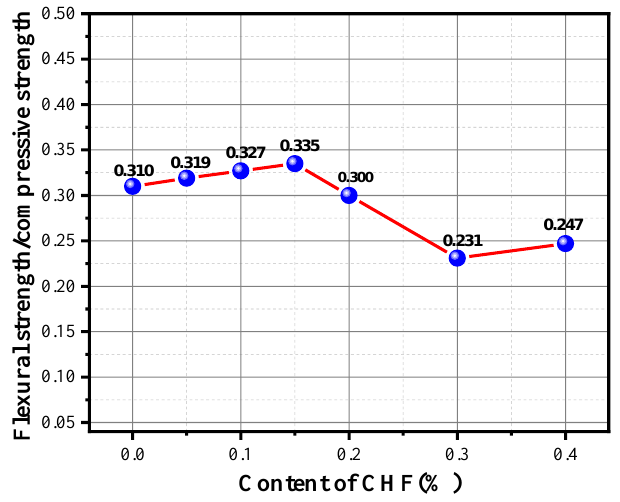
0.0 Figure 15. Influence of the content of CHF on the F/C of the material. Figure 15. Influence of the content of CHF on the F/C of the The change in the porosity of foamed concrete will influence its strength. Figure 16 shows the corresponding relationship between the porosity of the foamed concrete and its 28-day compressive strength and flexural strength. Figure 16. Corresponding relationship between porosity and strength of CHF foam concrete. The relationship between the density and the compressive strength and flexural strength of the cow hair fiber-reinforced foam concretes was linear when the addition of CHF was between 0 and 0.2 wt%, and this result had good agreement with the findings given elsewhere [43]. This shows that a reduction in porosity will thicken the pore wall structure inside the foam concrete, thereby effectively improving the strength of the ma- terial. However, when the content of CHF was up to 0.3% and above, with a further re- duction in porosity, the strength of the material showed a slight downward trend. It may be concluded that the higher CHF content will cause problems, such as agglomeration and uneven dispersion, in the foam concrete and that the agglomerated CHF will lead to